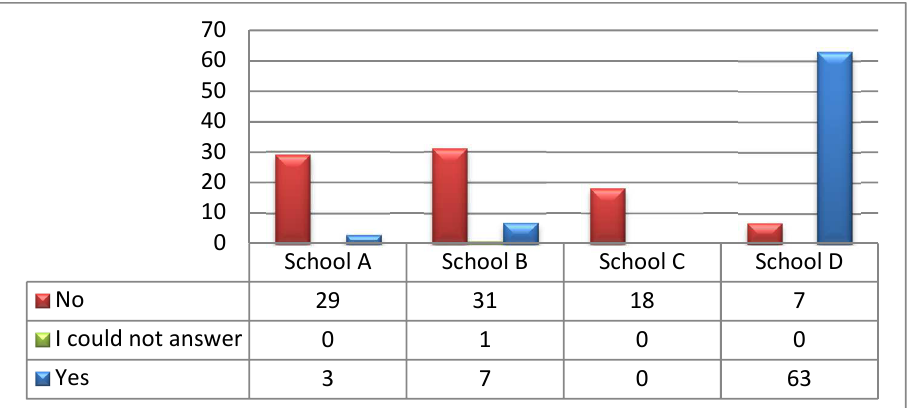
Figure 2: Students' access to computer laboratories in